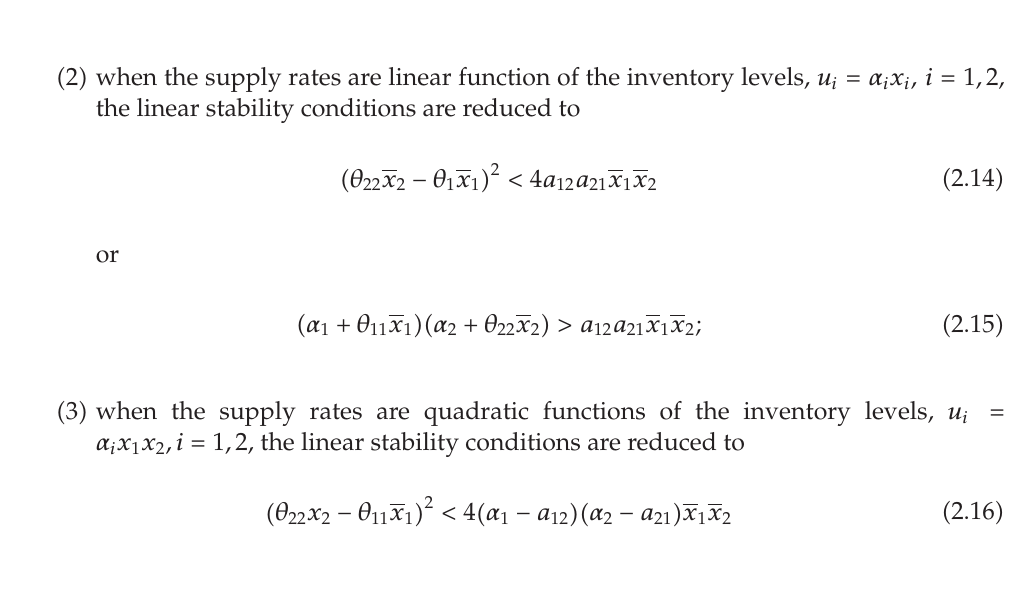
Figure 1: (cid:6) a (cid:7) and (cid:6) b (cid:7) are the first and the second inventory levels, respectively, of the uncontrolled system, with quadratic rates of supply. (cid:6) c (cid:7) is the trajectory of the inventory system in x 1 x 2 -plane.